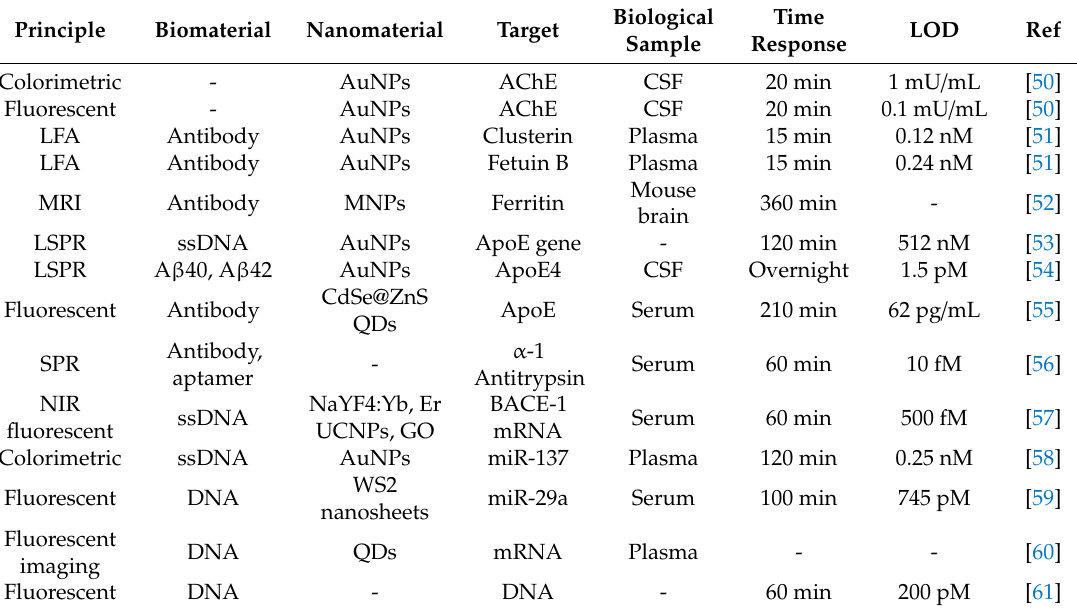
Table 1. Summary of the nanomaterial-based optical sensors of non-A β -Tau